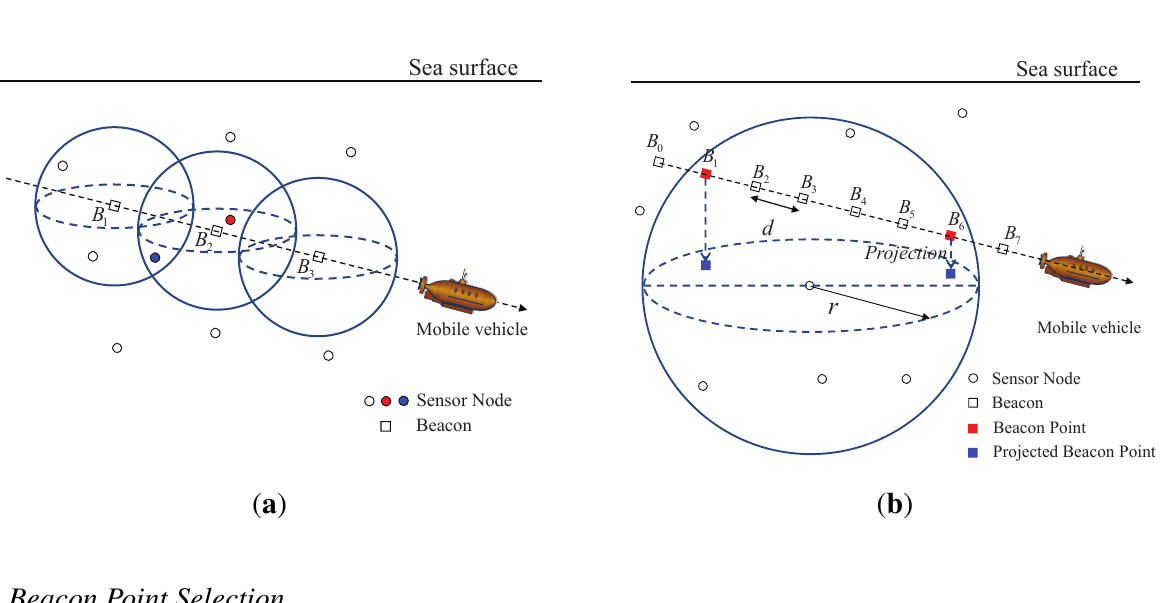
System environment, beacon point selection, and projection for